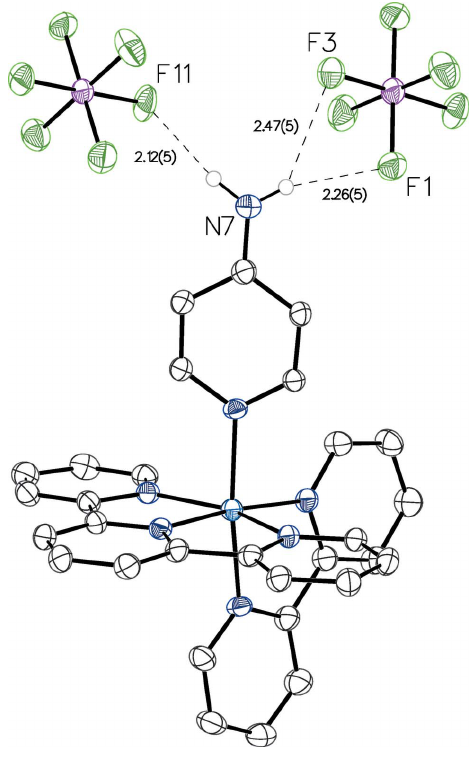
Figure 1 Anisotropic displacement ellipsoid plot drawn at the 50% probability level. Only the major component of the disordered PF 6 anion and only the NH 2 hydrogen atoms are displayed. Highly disordered solvent, located in channels parallel to [101], is not shown (see Refinement details